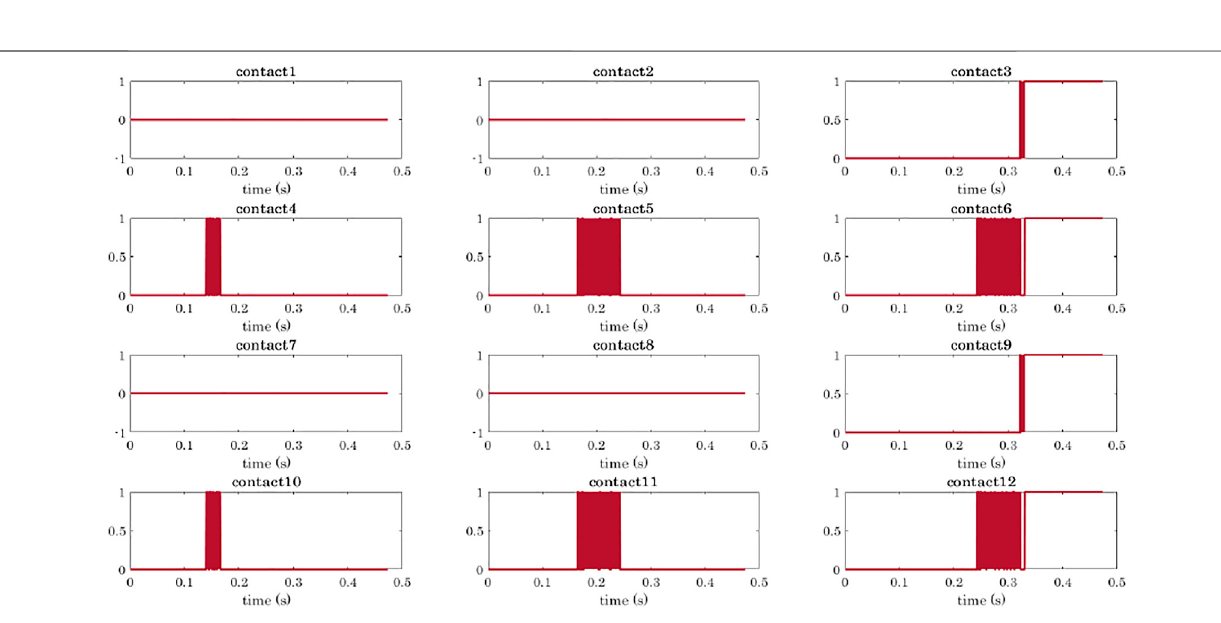
FIGURE 9 | Power grasp of a sphere with the four- fi ngered gripper: contact detection. Contact signals are ordered as the phalanges of the hand: the rows correspond to the fi ngers (from 1 to 4), and the columns to the phalanges (from 1 to 3). When the signal is equal to 0, it means that no contact has been detected on the corresponding phalanx. When a contact is detected the signal goes to